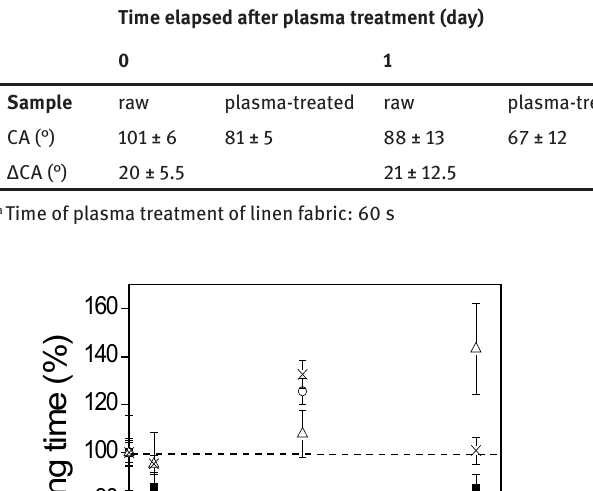
Table 2: Ageing of the plasma effects characterized by changing in water contact angle (CA) as a function of time elapsed from the plasma treatment. a